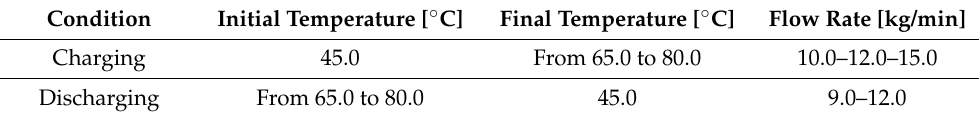
Table 3. Testing conditions applied to the two TES configurations during charging and discharging